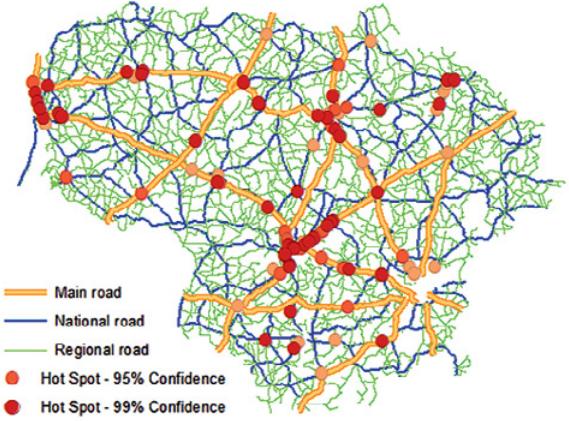
Figure 7. Accident hot spots for Dataset